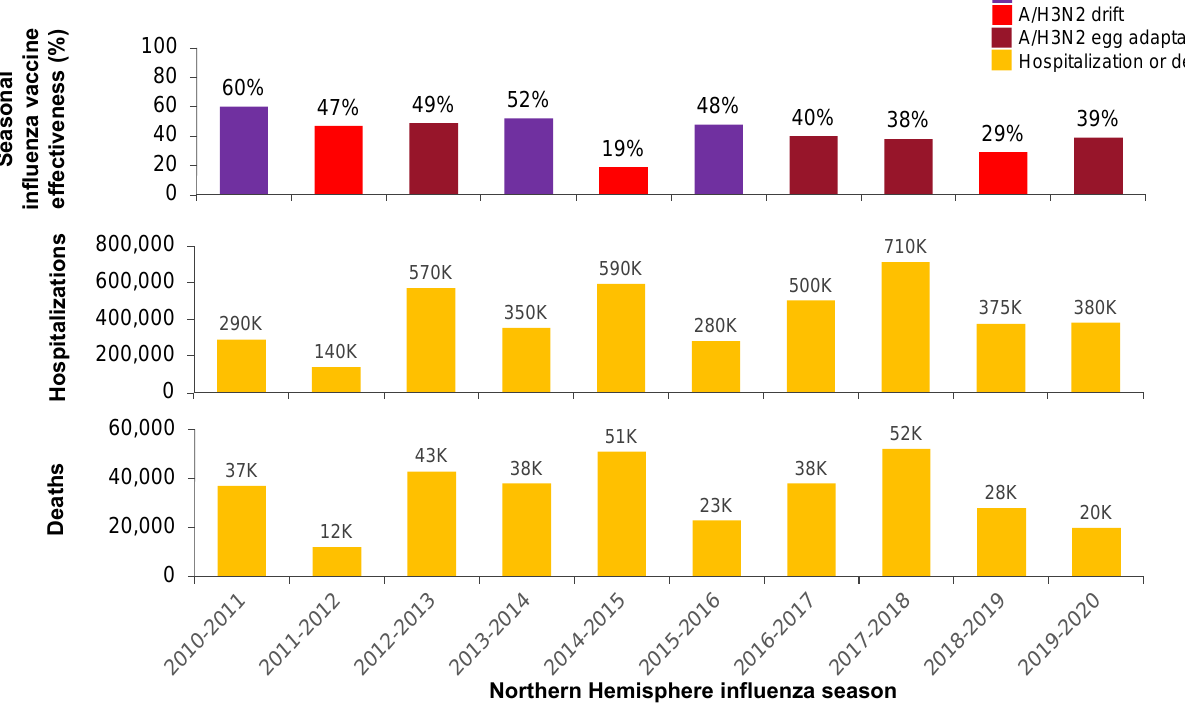
Figure 2. CDC-adjusted overall vaccine effectiveness estimates and documented A/H3N2 antigenic match or mismatch each season, as shown in Figure 1 ( top ), with numbers of US hospitalizations ( middle ) and deaths ( bottom ) due to influenza [15 – 24,26 – 29].